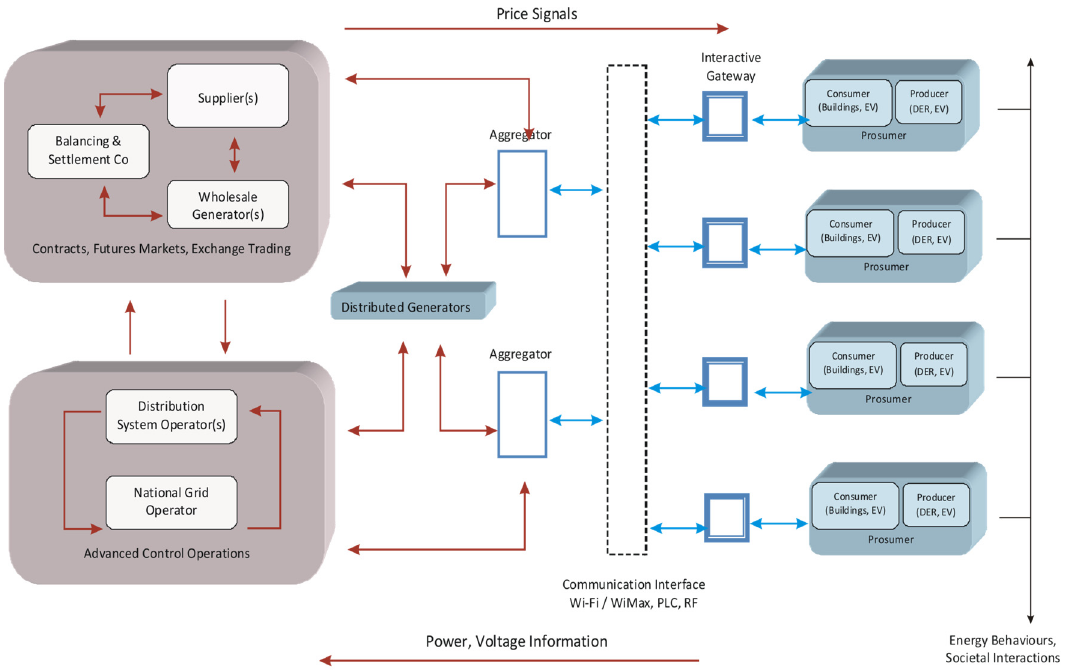
Figure 1. Agent based modelling (ABM) framework of a smart grid. Arrows indicate flow of power, information or cash between agents or entities. Aggregation of prosumers is introduced. The aggregator could be of physical and/or commercial nature.